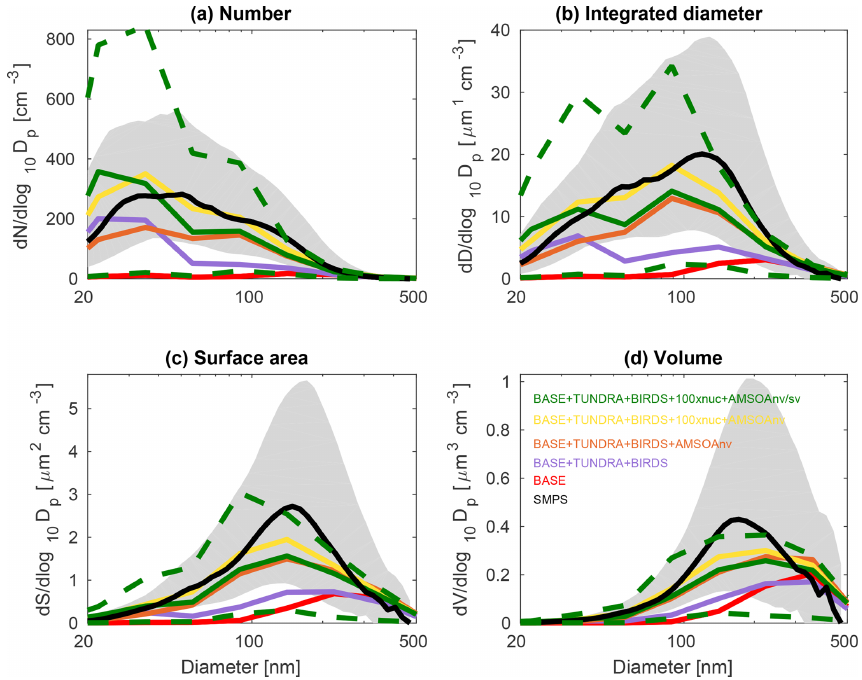
Figure 4. July and August 2016 median aerosol size distributions from scanning mobility particle sizer (SMPS) measurements at Eu- reka (80.1 ◦ N, 86.4 ◦ W; black; described in Sect. 2.1) and for five GEOS-Chem-TOMAS simulations (color coded as shown in the legend). Grey shading shows the SMPS 20th to 80th percentile and the green dashed lines show the 20th to 80th percentile for the BASE + TUNDRA + BIRDS + 100xnuc + AMSOAnv/sv simulation. Simulations are described in Table 1 and Sect. 2.3. The panels show the aerosol distribution moments with respect to (a) the aerosol number, (b) the integrated aerosol diameter, (c) the aerosol surface area, and (d) the aerosol volume distributions. Note the different vertical scale relative to Figs. 3 and 5. Table 2. Mean fractional error (MFE; Eq. 5) between the nine GEOS-Chem-TOMAS simulations (described in Table 1 and Sect. 2.3) and the SMPS measurements (described in Sect. 2.1) for summertime- (July and August 2016) median aerosol size distributions at Alert, Eureka, and during the CCGS Amundsen cruise shown in Figs. 3, 4, and 5, respectively.